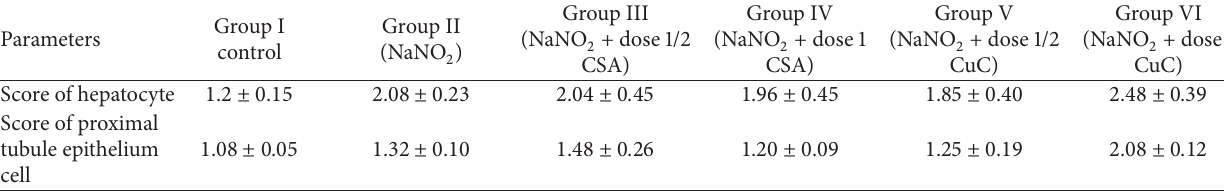
Table 3: The degeneration score of hepatocyte and proximal tubule epithelium cell in each experimental group.